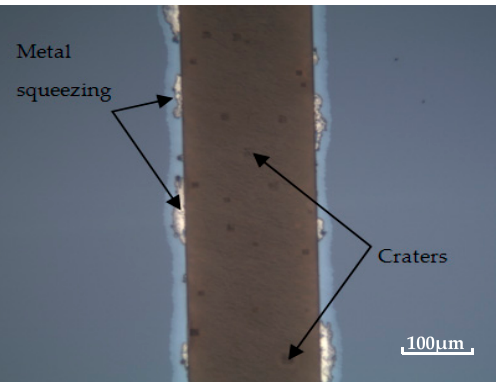
Figure 5. Metal squeezing and craters appear at the bonding interface with a high contact force of 5000 N.